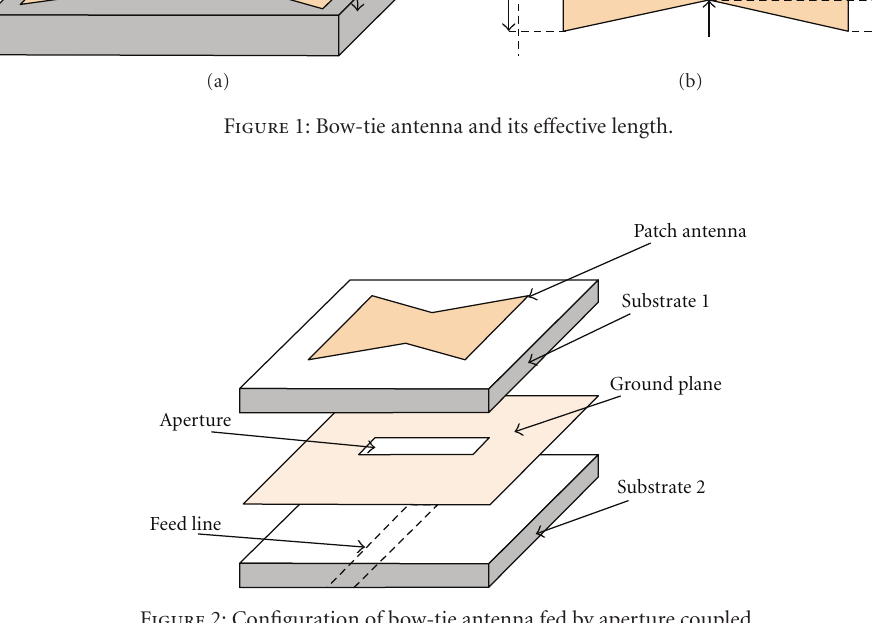
Figure 2: Configuration of bow-tie antenna fed by aperture coupled.